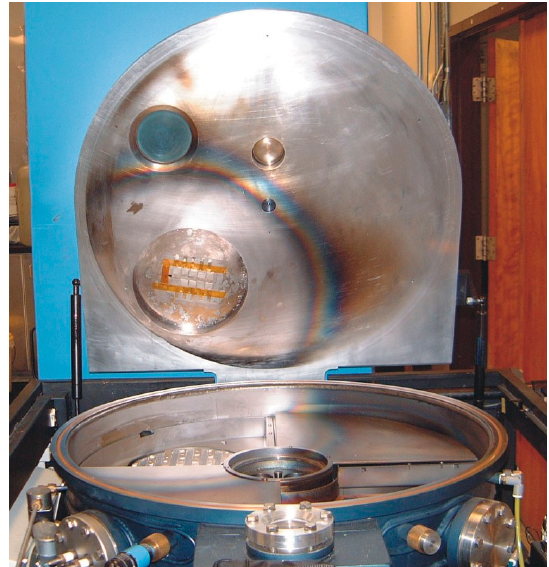
Figure 1. An radio frequency (RF)-sputtering unit with an 8 ″ nickel target decorated with different amounts of modifying elements ( bottom ) and an array of sandblasted nickel substrates with silicon witness substrates for composition measurements ( top ). The substrates are taped to a copper plate with circulating ice water or liquid nitrogen.